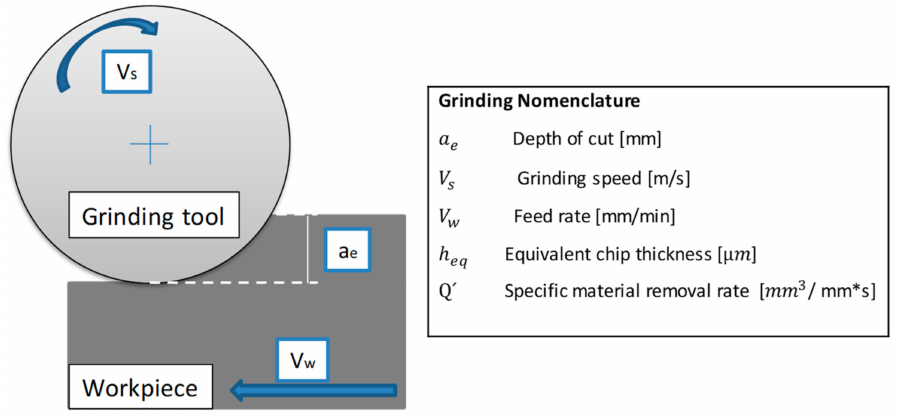
Figure 4. Grinding process parameters